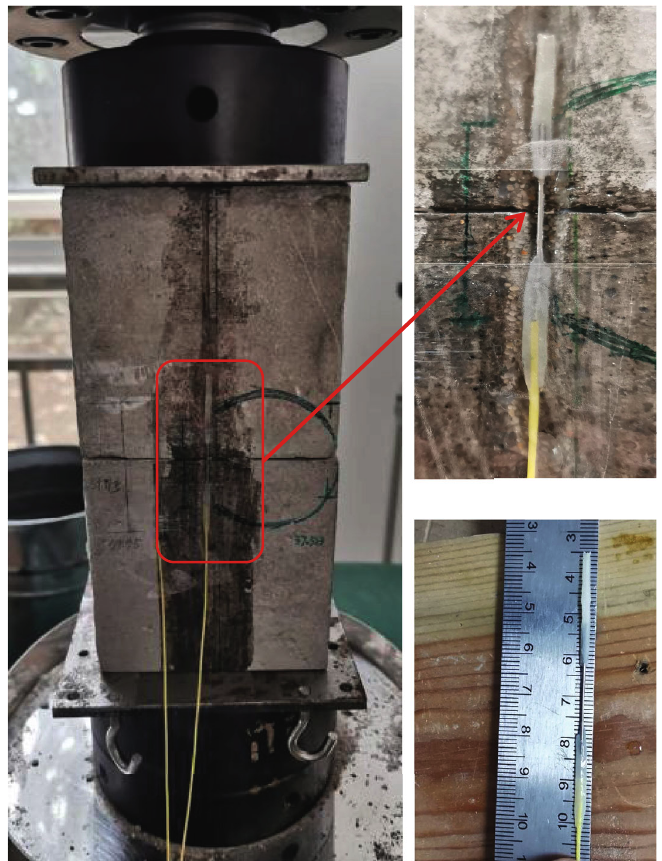
Figure 9: Uniaxial compression test of sensor in a cubic